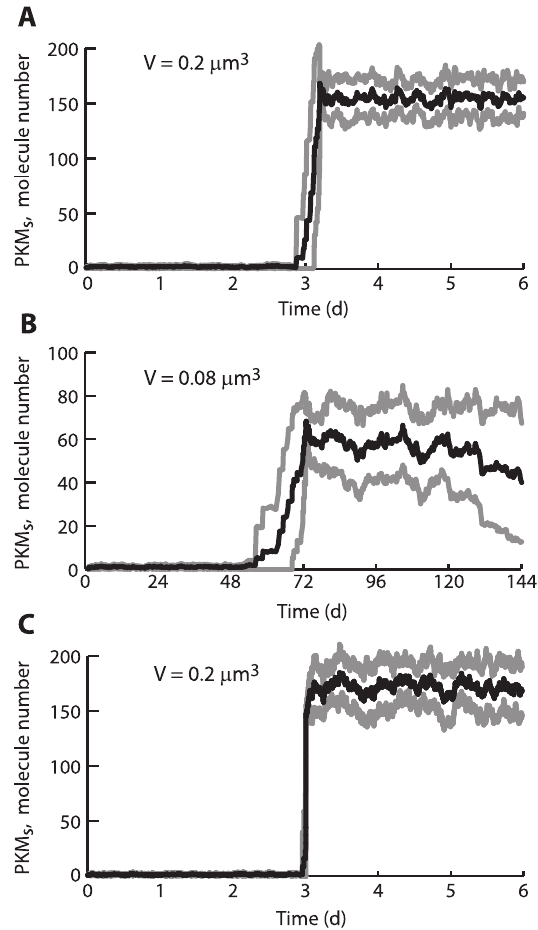
Figure 8. Stochastic simulations. A , For a volume of 0.2 m m 3 , both steady states are stable for at least 3 days. The black time course is for the average of PKM s over 20 simulations, in each of which PKM s was re- initialized to the upper steady state after the first , 72 h (the time of re- initialization varies somewhat between simulations because of variable time steps in the Gillespie algorithm). For all simulations the upper state remained stable for the next 3 days. The standard deviation of the 20 trajectories was not large (grey time courses, 6 1 SD from the average). B , For 0.08 m m 3 , the lower state remains stable, but the stability of the upper state degrades over several days. PKM s was re-initialized to the upper steady state after the first , 70 h. Over the following 3 days, the standard deviation increases as individual simulations fall back to the lower state. C , Similar to A , except that the rate of PKM s synthesis due to positive feedback is described by a series of elementary kinetic steps instead of by a Hill function.